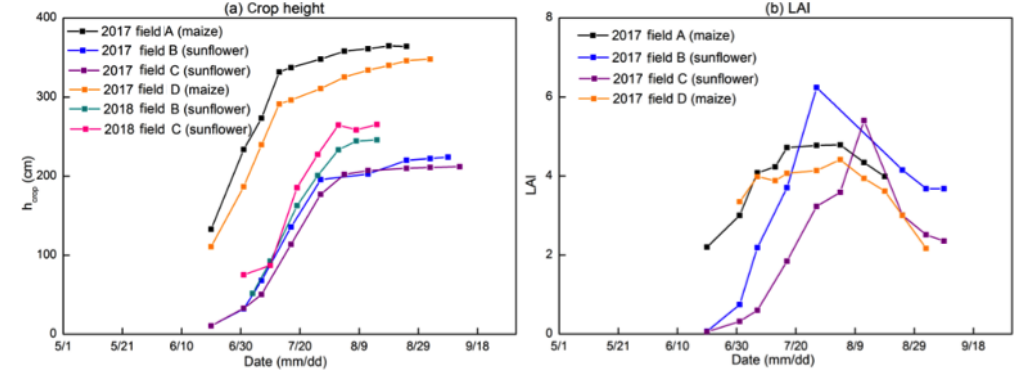
Figure 8. Observed crop height (a) and leaf area index (b) of the experimental field in Shahaoqu in 2017 and 2018.